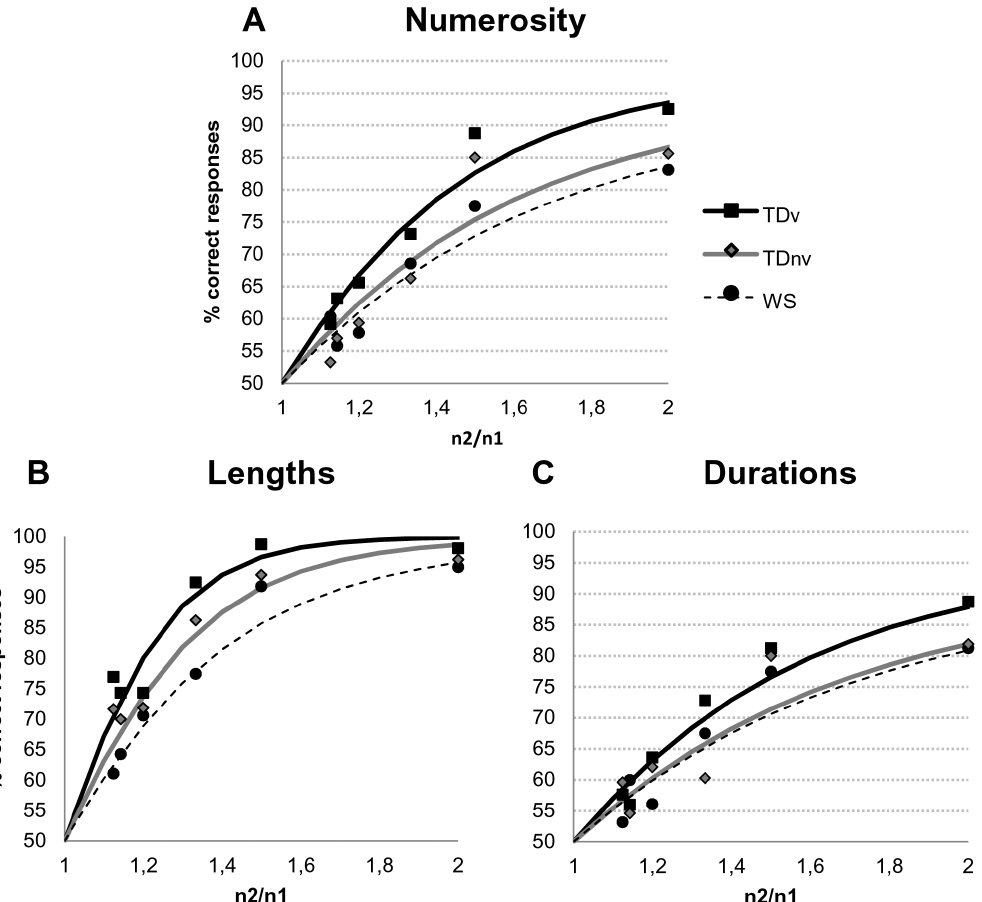
Figure 2. Accuracy data as a function of the ratio. Each panel respectively shows the percentage of correct responses as a function of the ratio in the numerical (A), spatial (B) and temporal (C) comparison tasks presented with logistic regression curves.